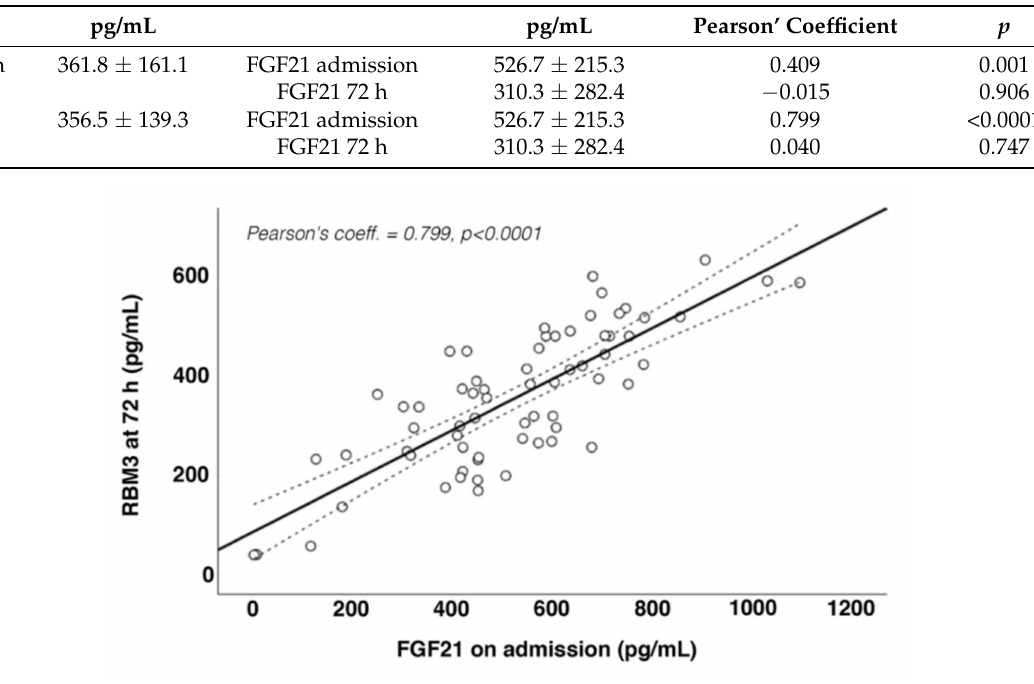
Figure 2. Association between fibroblast growth factor 21(FGF21) on admission and RNA-binding motif protein 3 (RBM3) at 72